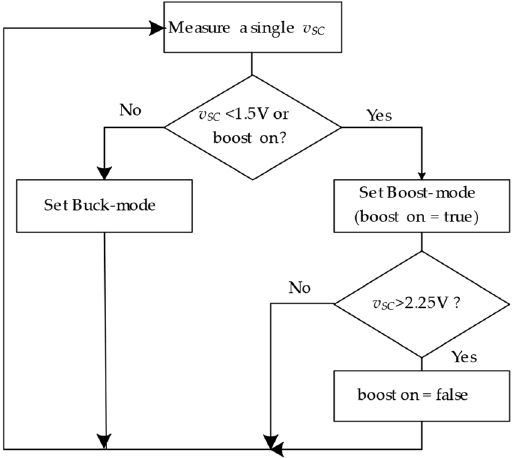
Figure 11. Mode selector